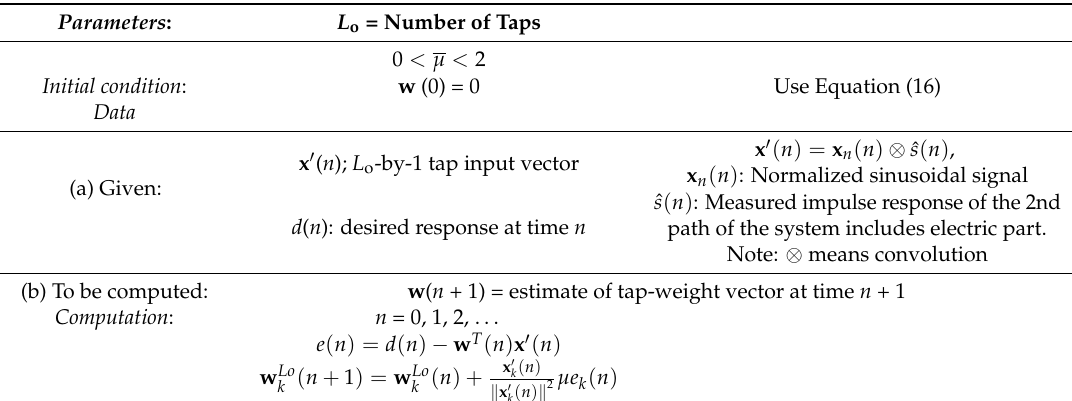
Table 1. Pseudo code of the OW-FxLMS